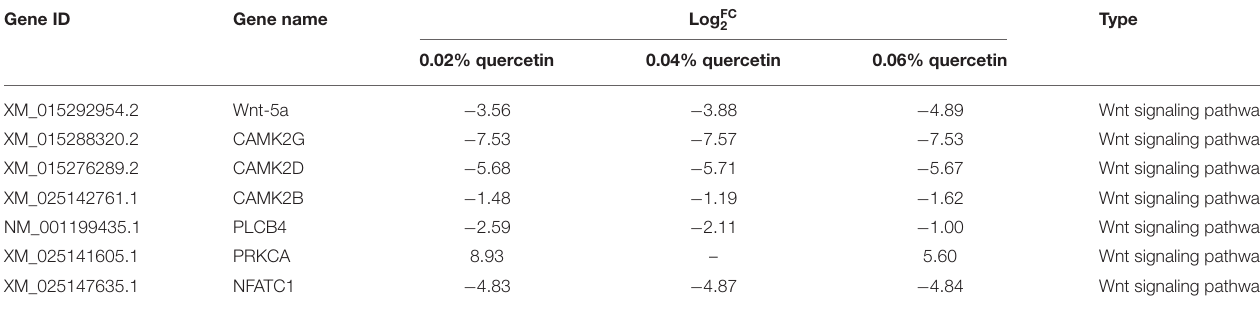
TABLE 8 | Summary of DEGs involved in calcium and phosphorus